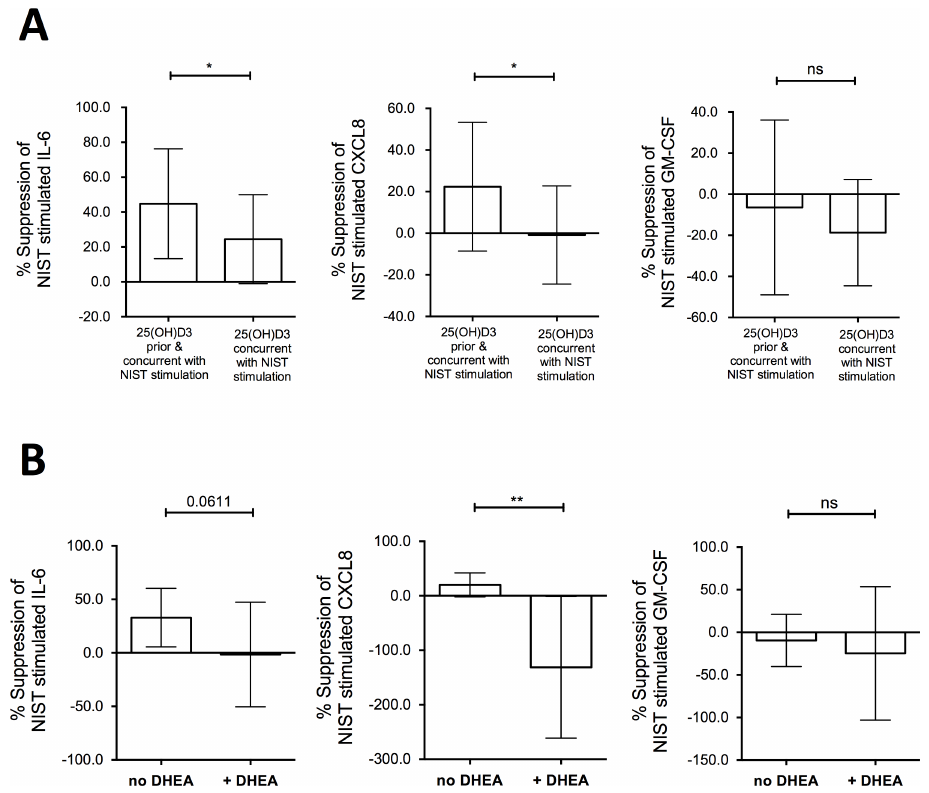
Fig 8. Effect of vitamin D pre-treatment of HBEC cultures on suppression of NIST induced IL-6 and CXCL8. (A) Percentage suppression of cytokine production in 50 μ g/ml NIST stimulated 24 hour cultures by concurrent and additional 24 hour pre-treatment with 100nM 25(OH)D3 compared to concurrent only; n = 7–9 (3–4 Healthy, 4–5 Asthmatic). Two-tailed paired t-tests. (B) Percentage suppression of cytokine production by 100nM 25(OH)D3 concurrent and pre-treatment in 50 μ g/ml NIST stimulated HBEC cultures, in the absence or presence of the G6PD inhibitor DHEA at 100 μ M; n = 7–9 (2–3 Healthy, 5–6 Asthmatic). Two-tailed paired t-tests. Statistical significance as follows: (cid:3) , p (cid:20) 0.05; (cid:3)(cid:3) , p (cid:20)